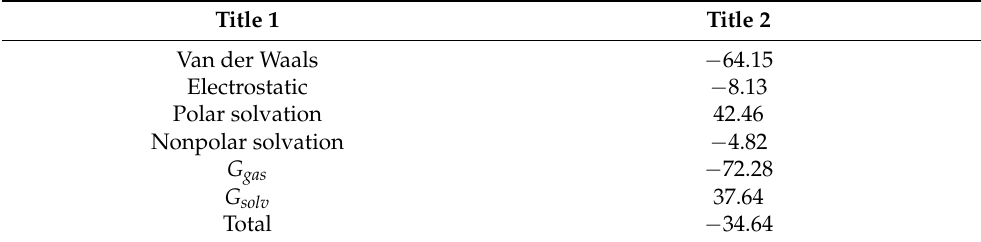
Figure 8. MD simulation of SPI and isoginkgetin interaction. ( A ) RMSD, radius of gyration, hydrogen bonding occupancy and amino acid energy contribution during simulation. ( B ) The representa- tive stereo structure of 11S–isoginkgetin complex. Table 3. Binding energy contribution of isoginkgetin–11S complex.